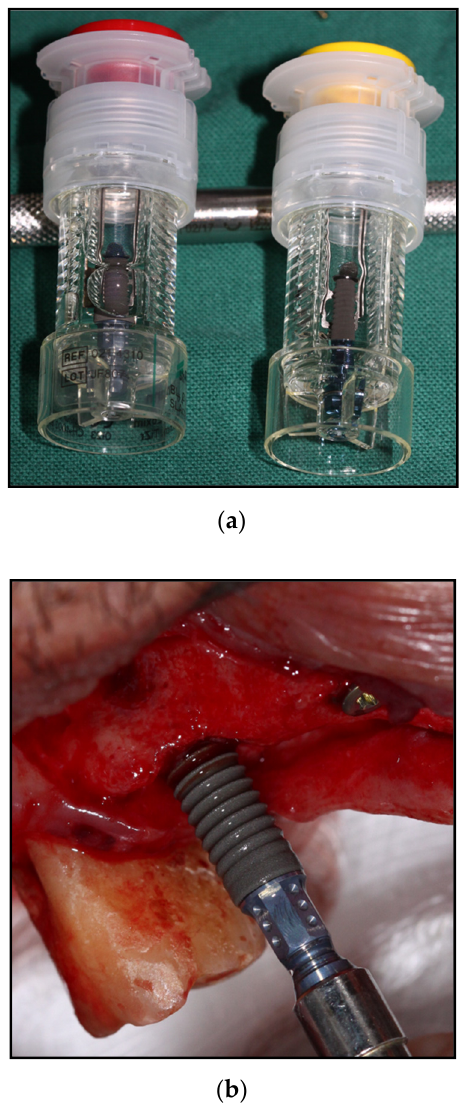
Figure 1. Straumann SLActive ® Implant system (Institute Straumann AG, Basel, Switzerland); ( a ) isotonic saline solution as novel storage to maintain surface bioactivity; ( b ) wettability of implant shown as blood drawn onto the implant surface.